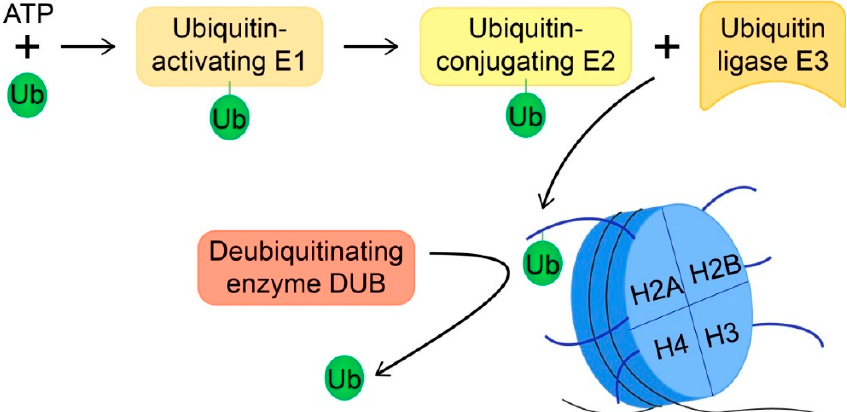
Figure 1. Schematic presenting the enzymatic machinery catalyzing the addition and removal of histone ubiquitination. Ubiquitination requires a ubiquitin-activating enzyme (E1), a ubiquitin-conjugating enzyme (E2), and a ubiquitin ligase (E3). As depicted, histones are typically ubiquitinated on lysine residues contained within histone tails that extend away from the nucleosome. Ubiquitin (Ub) is removed from histones (i.e., target proteins) by a deubiquitinating enzyme